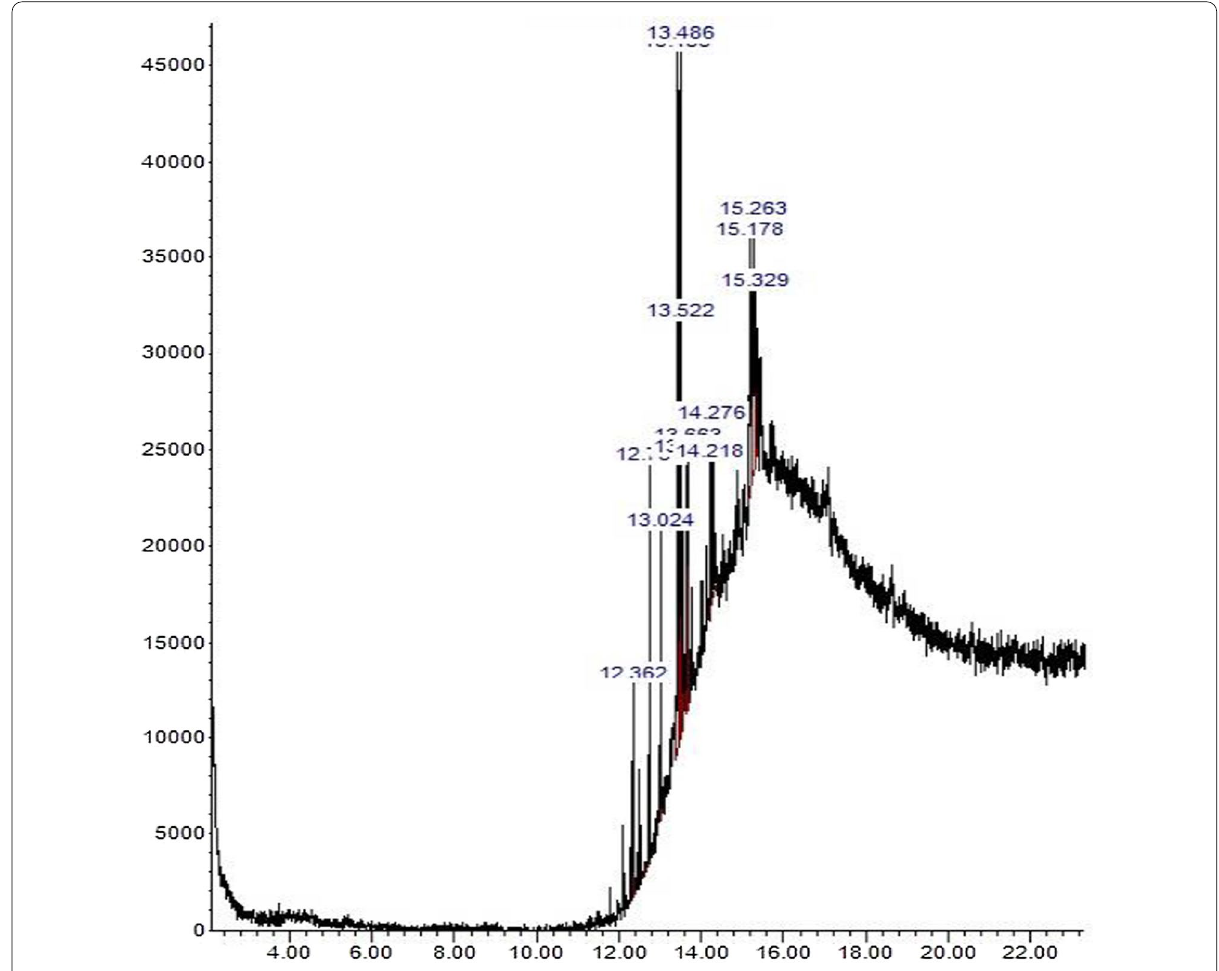
Fig. 1 Mass chromatogram of ethanolic extract of leaves of Jatropha